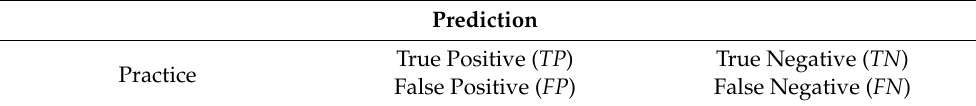
Table 6. Confusion